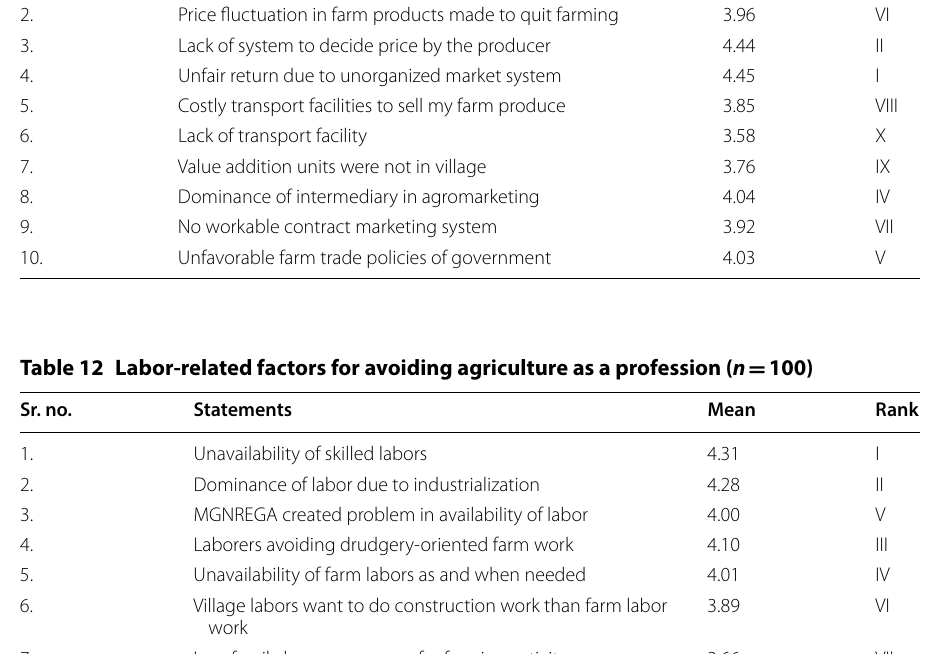
Table 11 Market-related factors for avoiding agriculture as a profession ( n Sr. no.